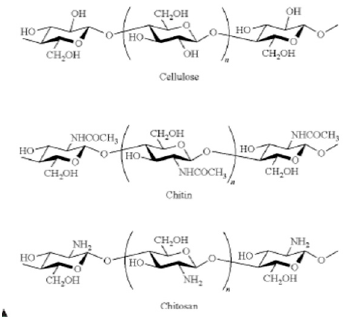
Figure 5. Chitin and chitosan chemical structure compared to cellulose.